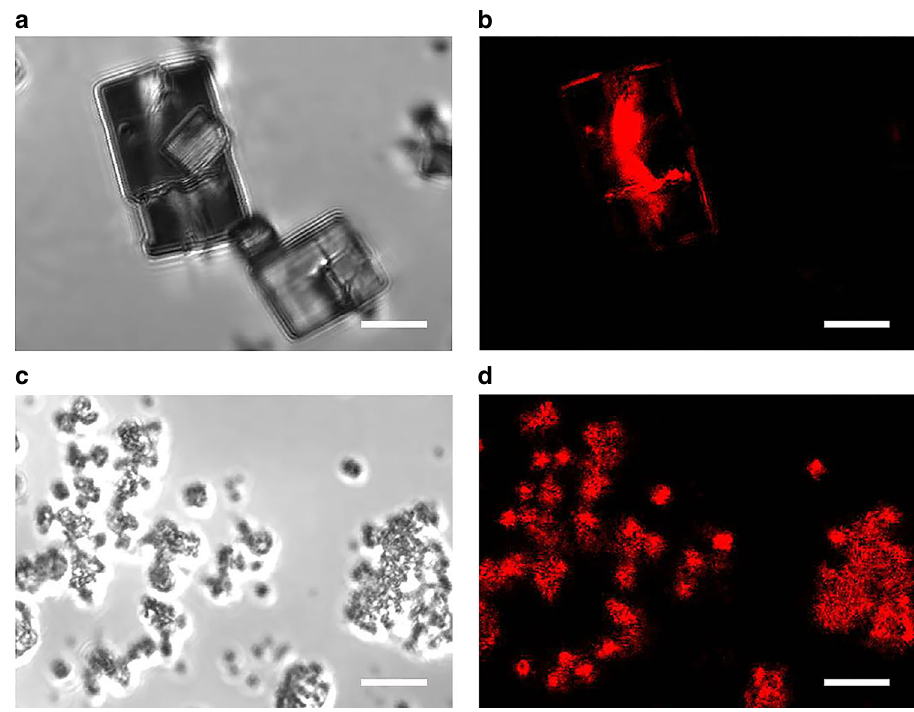
Fig. 3 Micrographs and CFM images. Views of MFM-100a a micrograph, b CFM and of MFM-100d c micrograph, d CFM. The scale bar is 5 μ m in all images. The fl uorescence (shown in red colour) indicates the presence of crystal defects determined by the oligomerisation of furfuryl